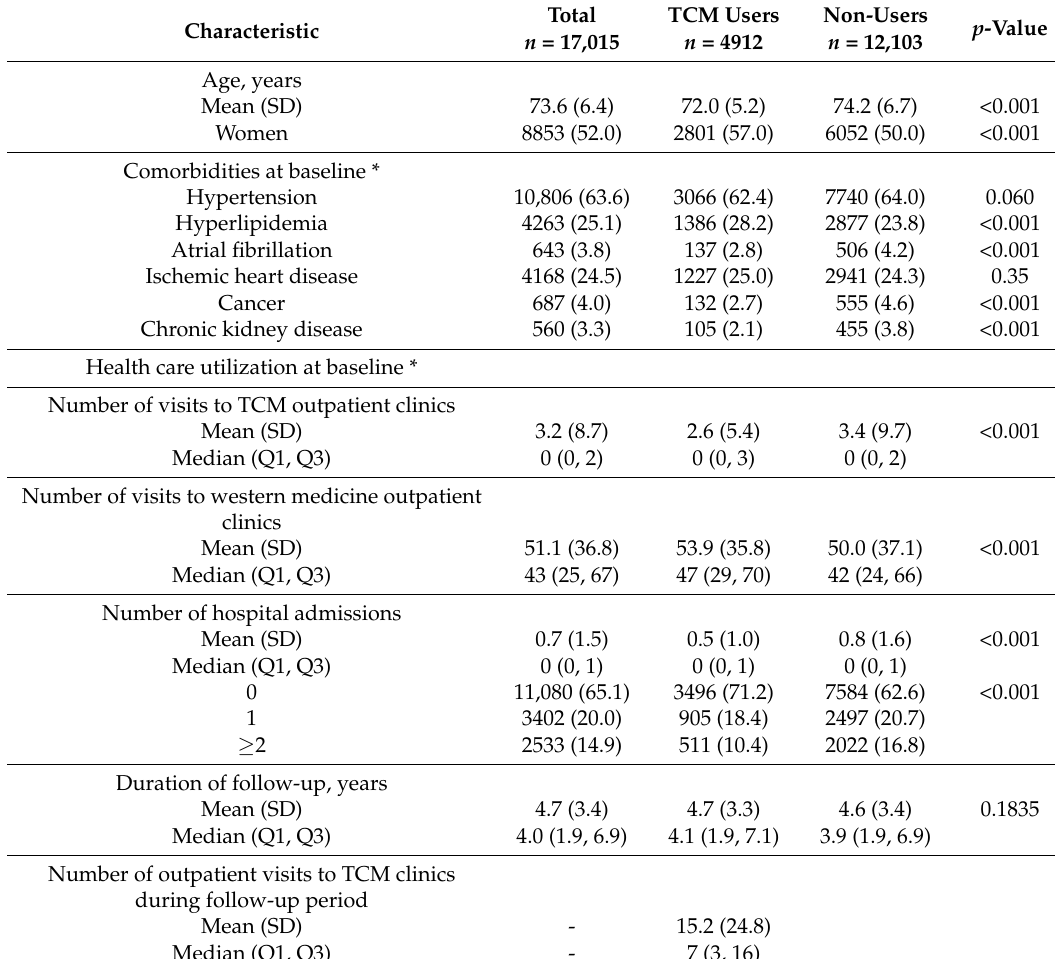
Table 1. Baseline characteristics of patients with newly treated diabetes receiving or not TCM